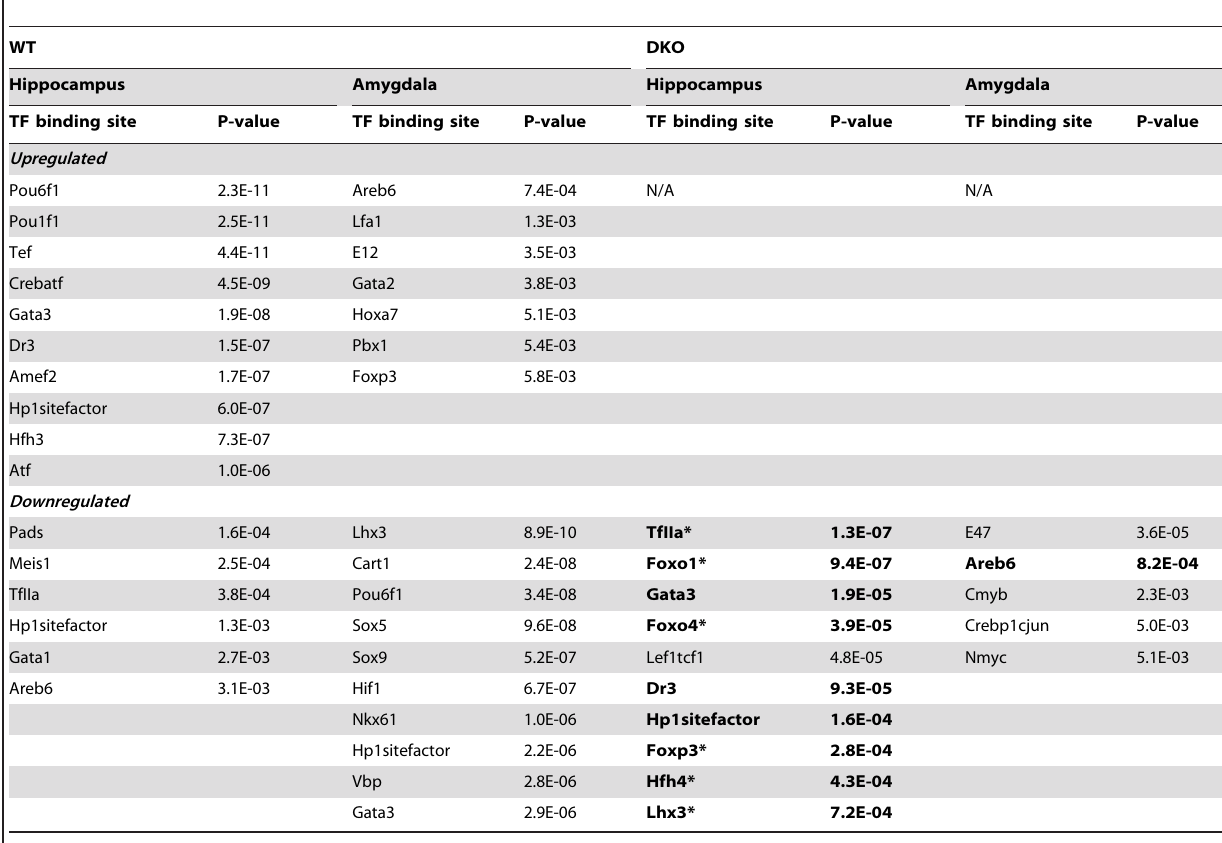
Table 3. Top 10 TF binding sites overrepresented in genes regulated at 48